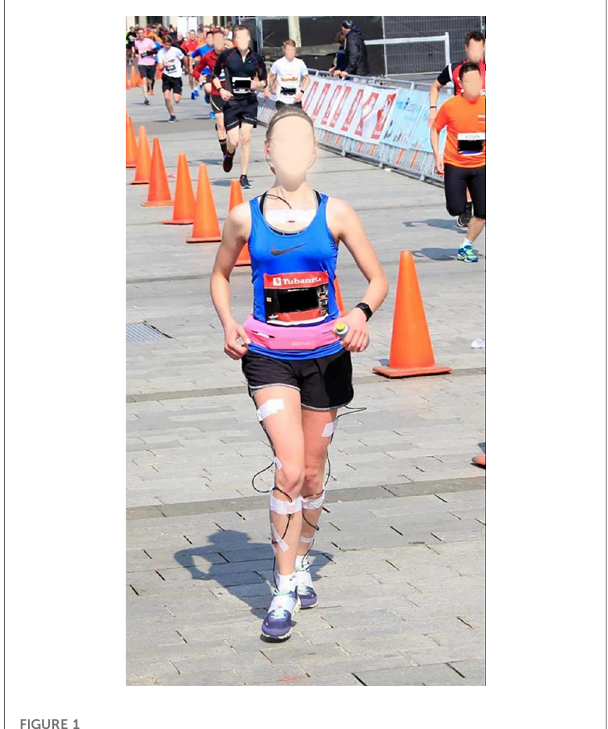
FIGURE 1 One of the runners a few meters before the fi nish line. The bodypack and battery pack are placed in the pink belt. White tape is visible, which covers the sensors and fi xates sensor